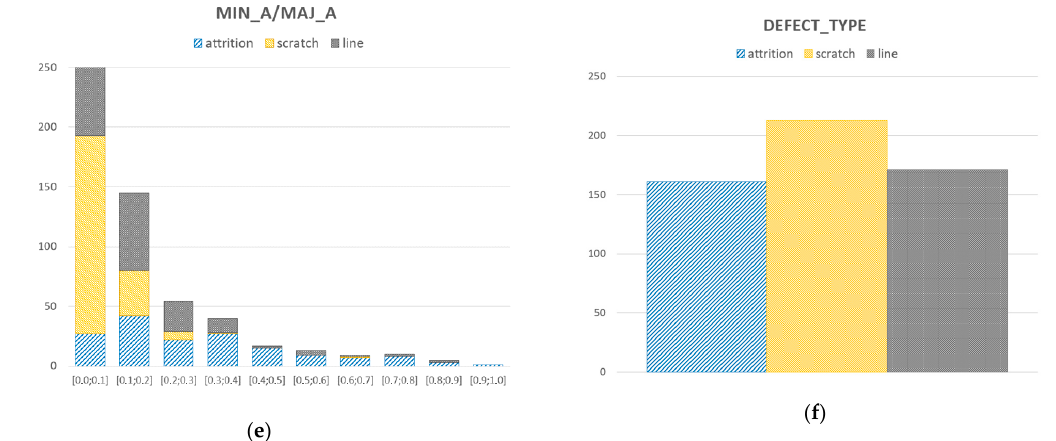
Figure 7. Histograms of the distributions of attribute values for the classification of defects of rolled strips into subclasses “abrasions”, “scratches”, “lines” (attritions—161, scratches—213, lines—171) (obtained by Weka).